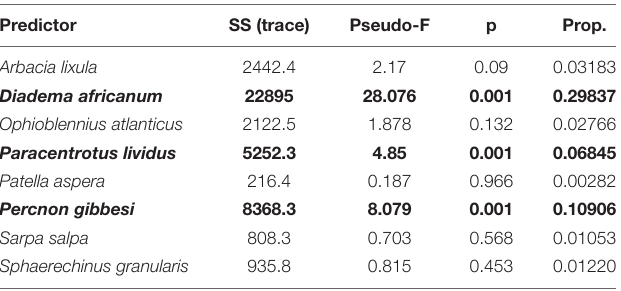
TABLE 2 | Marginal tests for distance-based linear modeling to predict Bray-Curtis similarities between benthic transect samples ( n = 68) with herbivore and grazer taxa densities as predictors (significant predictors in bold; SS, Sum of Squares; Prop., proportion). Predictor